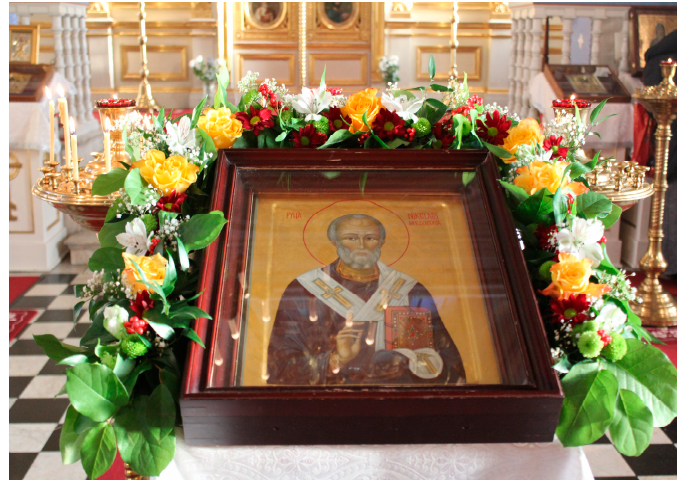
Figure 3. The icon of St Nicolas decorated with flowers. Photo by the author.